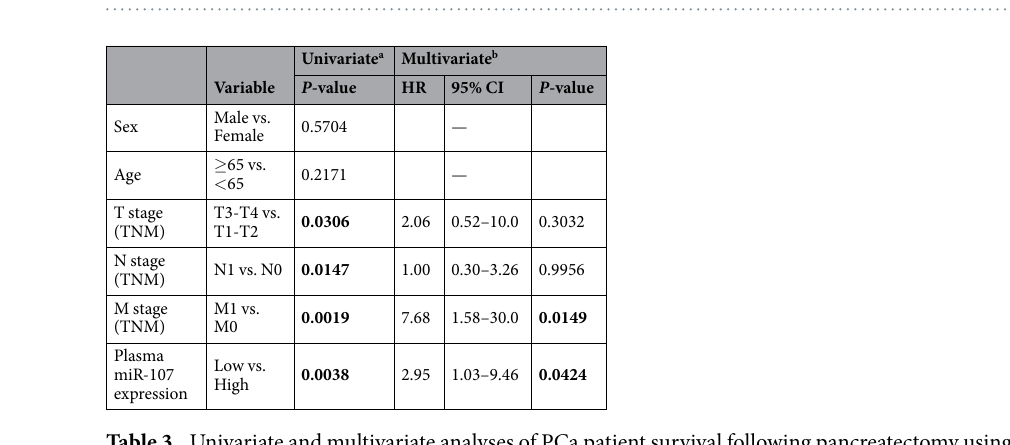
Figure 3. Investigation into whether plasma miR-107 levels reflect tumor dynamics in plasma, pancreatic tissue and exosomes. ( a ) Comparison of miR-107 expression between normal and cancerous pancreatic tissues. The expression of miR-107 was significantly higher in 6 normal pancreatic tissues than in 6 cancerous pancreatic tissues ( P = 0.0272). ( b ) miR-107 plasma levels in pre- and postoperative samples from PCa patients who underwent curative pancreatectomy. miR-107 plasma levels in paired samples collected before and nearly 1 month after surgery from 10 PCa patients who underwent curative pancreatectomy. Plasma miR-107 was significantly elevated in the postoperative plasma samples ( P = 0.0186). ( c ) miR-107 expression level in exosomes extracted from the plasma of PCa patients and healthy volunteers. The expression level of miR-107 in exosomes extracted from plasma was investigated in 4 PCa patients and 4 healthy volunteers. Exosomal miR- 107 in plasma was significantly down-regulated in PCa patients compared with healthy volunteers ( P = 0.0222). ( d ) Decreased plasma miR-107 is associated with prognostic outcomes in PCa patients. A prognostic analysis revealed that a low miR-107 plasma level was significantly associated with a worse cause-specific survival rate in all PCa patients ( P < 0.0001), a worse cause-specific survival rate in PCa patients with curative pancreatectomy ( P = 0.0038), and a worse disease-free survival rate in PCa patients with curative pancreatectomy ( P = 0.0159).